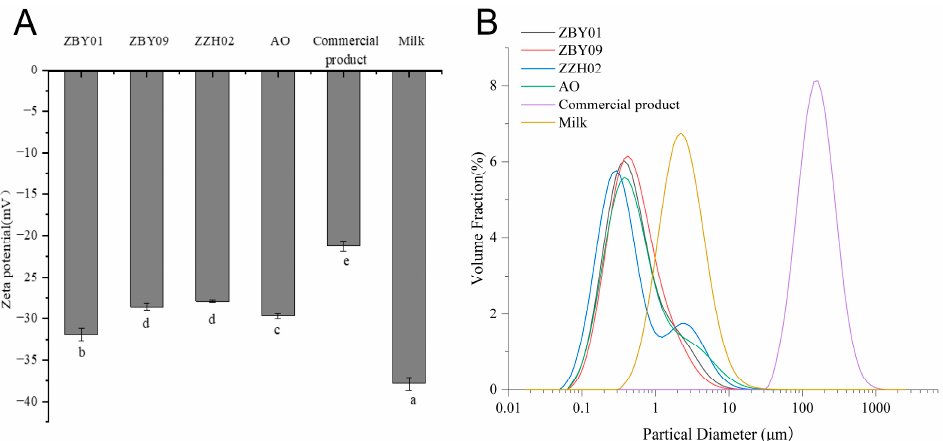
Figure 2. The ζ -potential ( A ) and particle size distribution ( B ) of commercial oat milk product, UHT bovine milk, and oat milk products produced from different cultivars. a,b,c,d,e, p < 0.05. The average particle size was also analyzed. Oat milk produced from ZZH02 had the lowest average particle size (0.43 ± 0.02 µ m). The average particle size of the oat milk produced from ZBY01, ZBY09, and AO was 0.48 ± 0.004 µ m, 0.48 ± 0.009 µ m, and 0.54 ± 0.02 μ m, respectively. These particle sizes were smaller than those of UHT milk (2.18 ± 0.02 μ m). The particle size of the commercial oat milk was the largest (147.41 ± 4.001 μ m). However, a bimodal distribution could be observed for the ZHH02 oat milk (Figure 2B). Large particles, with an average particle size of 2 μ m, accounted for a certain portion.